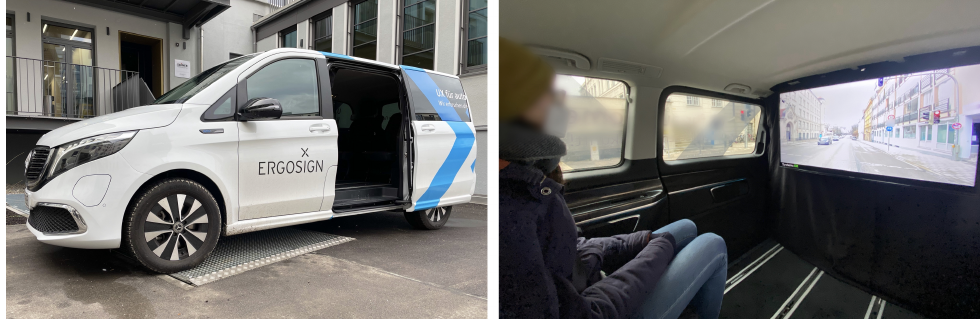
Figure 5. Example of a video-based Wizard-of-Oz setup that we created for our in-vehicle interaction studies [44] inspired by the works of Karjanto et al. [66] and Detjen et al.